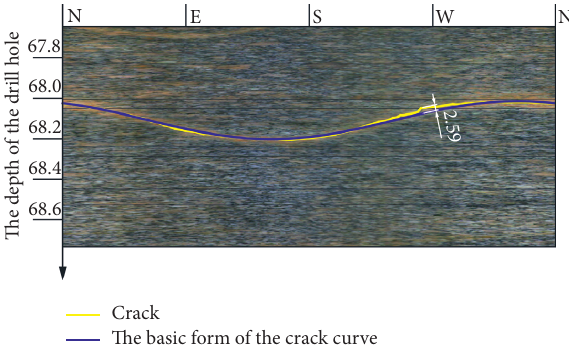
Figure 6: Schematic diagram for calculating fracture roughness.